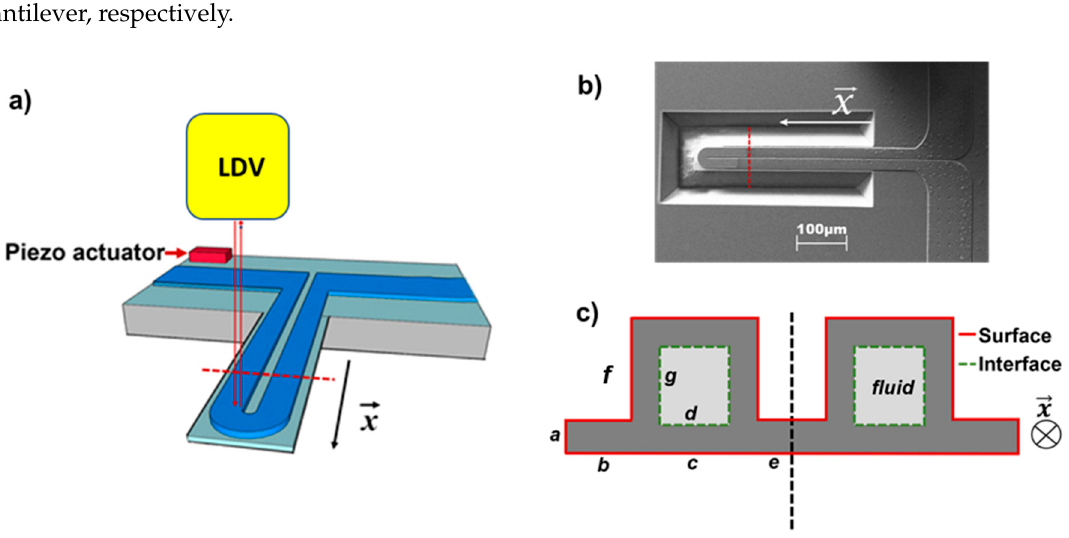
Figure 1. ( a ) Schematic of the experimental system. The microchannel cantilever vibrates in vacuum environment with a pressure below than 1 × 10 − 3 mbar in order to ensure high quality factor resonance peaks. ( b ) Scanning electron microscope (SEM) image from the top of the sensor chip. ( c ) A cross-sectional illustration of the cantilever (dotted red lines in ( a , b )) denoting our definition of interface and surface, as well as the geometric description of the lengths used in our calculation (‘ a ’ to ‘ g ’).